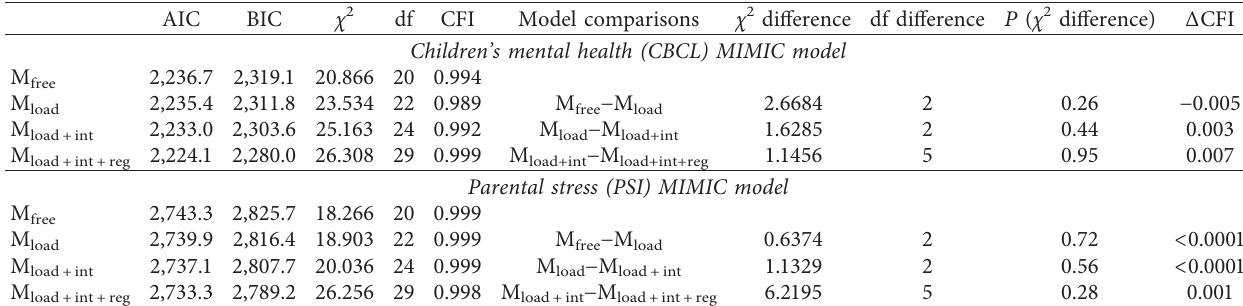
Figure 1: Path diagram of the MIMIC models for the analysis of the relationships between the evaluation of eating habits and the evaluations of the mental health of children and parental stress. Standardized parameters of loadings, regression coefficients, and residuals are reported for mothers (fathers). ∗∗∗ significant at 0.001 level, ∗∗ significant at 0.01 level, and ∗ significant at 0.05 level. Children’s eating behavior subscales: FR: food responsiveness, EOE: emotional overeating, EF: enjoyment of food, DD: desire to drink, EUE: emotional undereating, FF: food fussiness; parenting stress index subscales: PD: parental stress, PDCI: parent-child dysfunctional interaction, DC: difficult child; and child behavior check list subscales: OTHER: other problems, INT-CBCL: internalizing CBCL symptoms, and EXT-CBCL: externalizing CBCL Table 5: Multigroup invariance measurement of MIMIC models M free , M load , M load+int , and M load+ int+reg , between mothers and fathers both for children’s mental health (CBCL) and for parental stress (PSI).